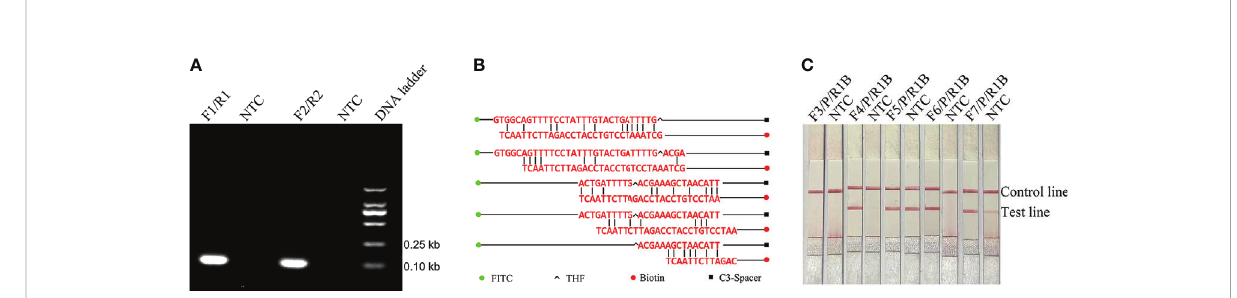
FIGURE 1 Ampli fi cation performance of the primers and probe. (A) Image of an agarose gel showing the RPA results of primer pairs targeting a speci fi c fragment. The name of primer pairs are indicated at the top of each lane. NTC, no template control. The image represents the results of three independent experiments. (B) Pairing analysis and sequence modi fi cations of the reverse primer-probe sets for the detection of E. faecalis using Primer Premier 5 software. Relevant DNA bases of the probe and reverse primer had been excluded. All the DNA strands are shown as horizontal lines and matching bases are indicated by vertical lines. Molecular markers are listed under the fi gure. (C) Screening of the forward primers. Image showing the RPA-LFS results for different forward primers. The names of the primer-probe pairs are indicated at the top of each lane. NTC, No Template Control. The image represents the results of three independent